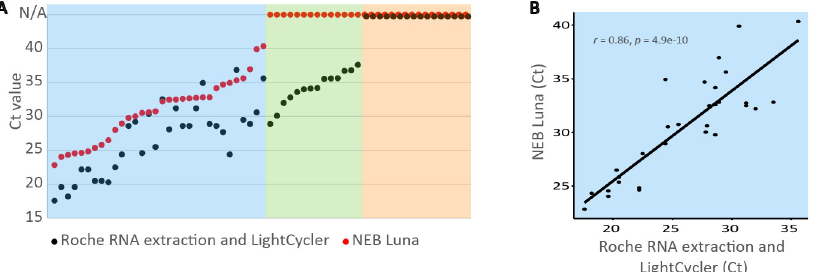
Fig 3. ( A ) Roche RNA extraction/RT-qPCR and NEB Luna RT-qPCR for SARS-CoV-2 detection in 62 mouthwash samples from hospital patients. The NEB method detects the virus when Ct of the Roche method is less than 29 (blue box). Dots at N/A show no amplification of the viral target. ( B ) Correlation of Ct values between direct NEB assays and RNA extraction followed by Roche assays for mouthwash samples positive with both